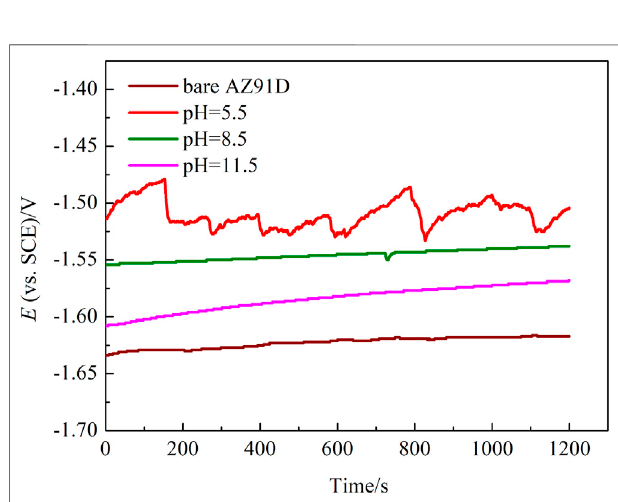
FIGURE5| OpencircuitpotentialcurvesofbareAZ91DandpH – treated samples in SBF.